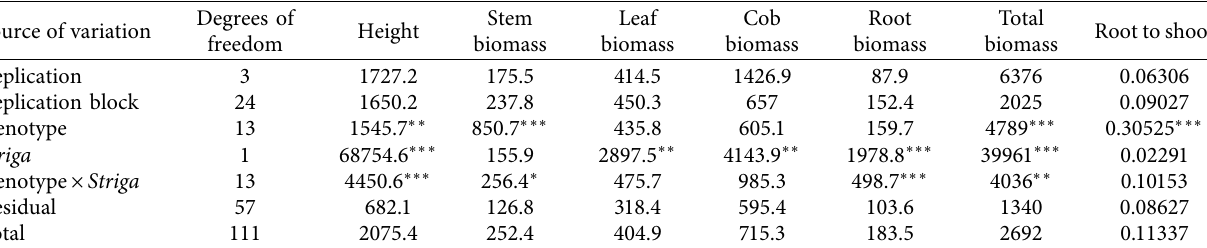
Table 2: Analysis of variance for maize traits recorded in a greenhouse experiment at the University of Zimbabwe. Source of